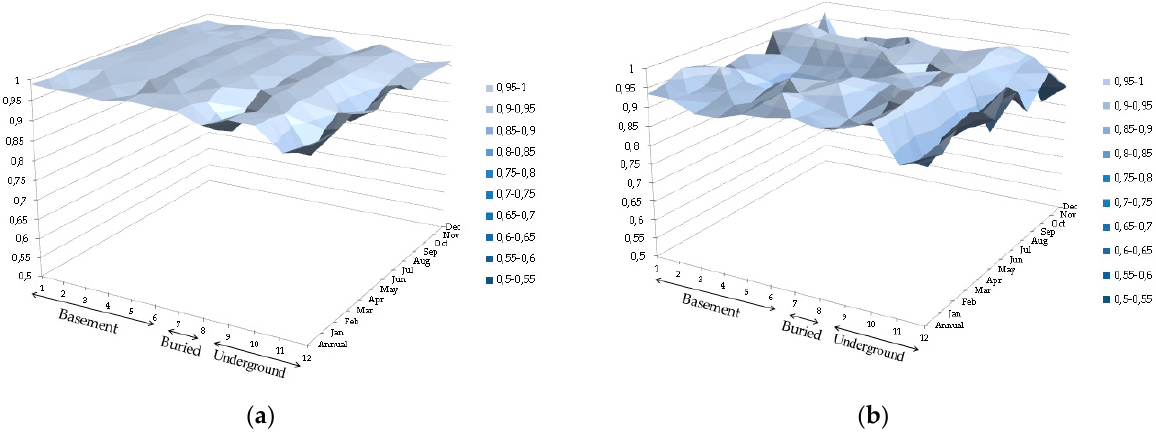
Figure 7. Temperature damping in the buildings analyzed ( a ) Mean daily temperature damping; ( b ) Mean monthly temperature damping.